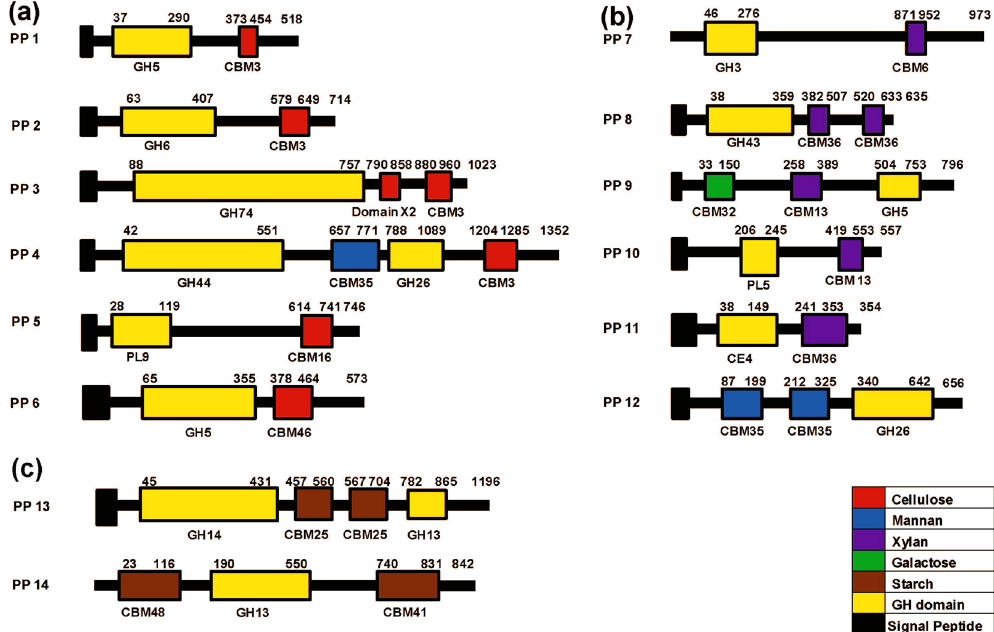
Figure 2. Domain architecture of CBM containing polypeptides identified in P . Polymyxa A18 genome. The numbering above the polypeptides shows the amino acid positions of the module boundaries as determined by HMM scan search. CBMs are color coded according to the previous knowledge on their binding affinity and categorized on the basis of ( a ) cellulose binding, ( b ) hemicellulose binding and ( c ) starch binding. Black and yellow boxes represent a potential signal sequence and the catalytic domain, respectively.